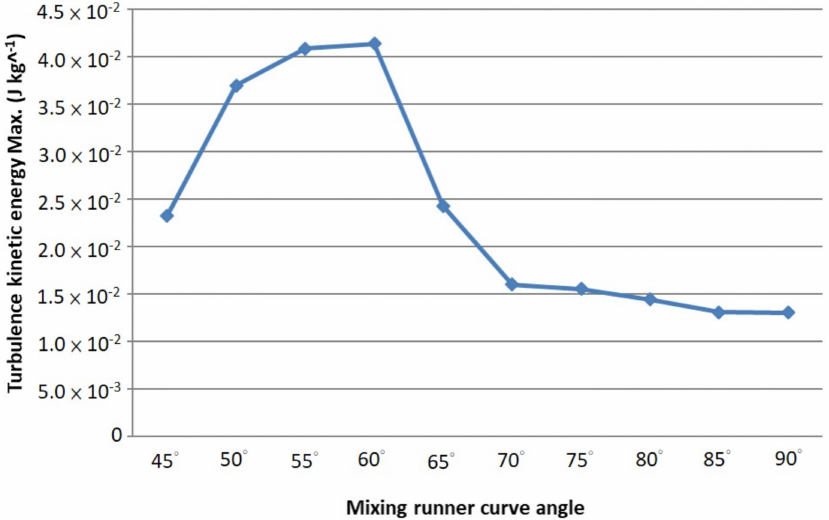
Figure 4. The transient maximum turbulence kinetic energy of the microfluidic in the mixing runner area during the first stage of rotation in the disc.